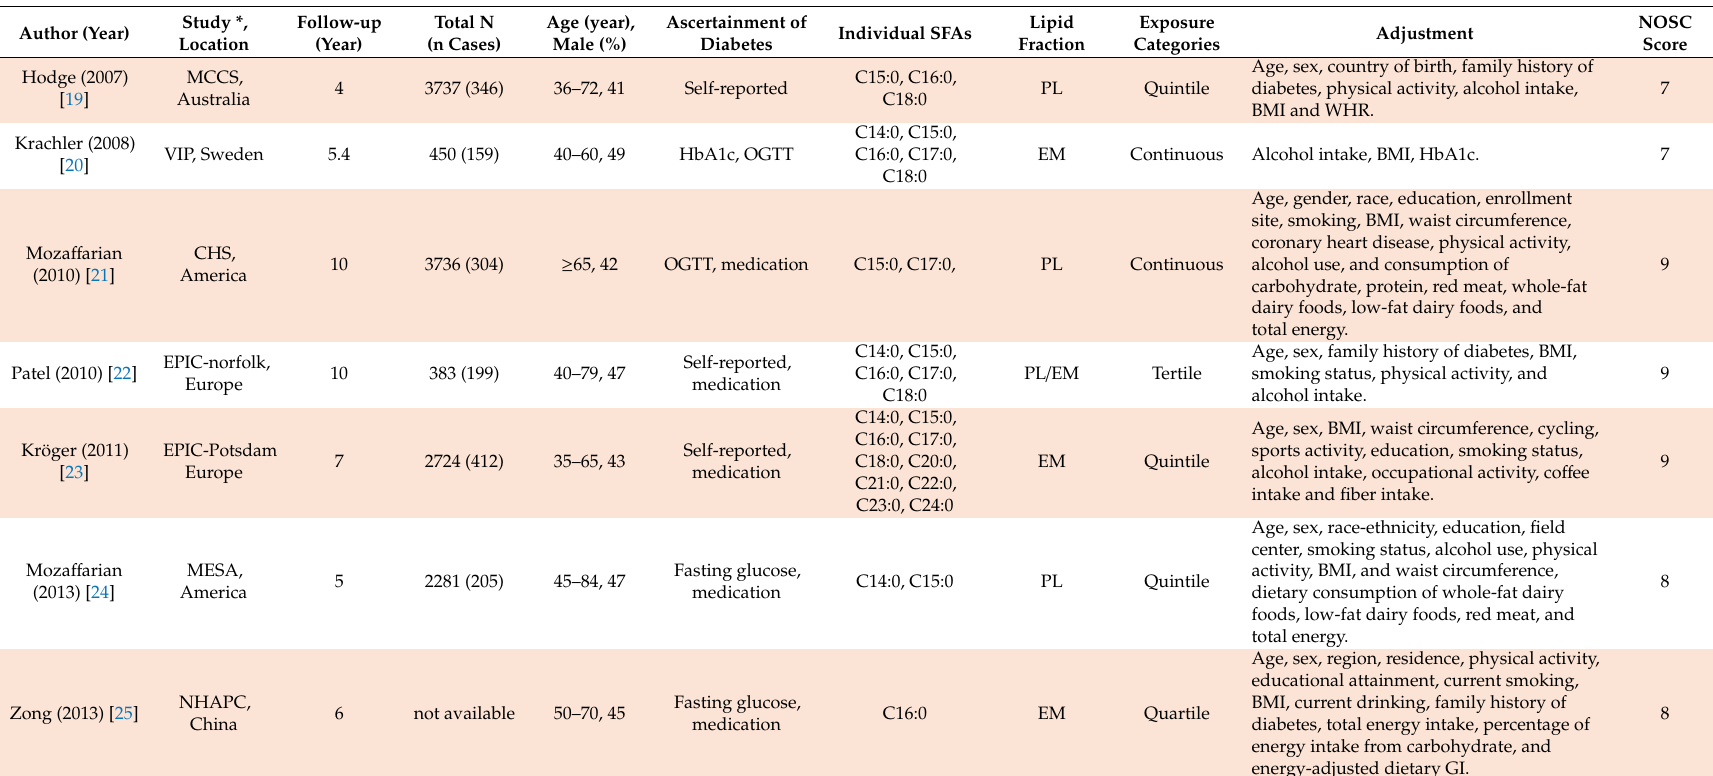
Table 1. Characteristics of the included studies for systematic